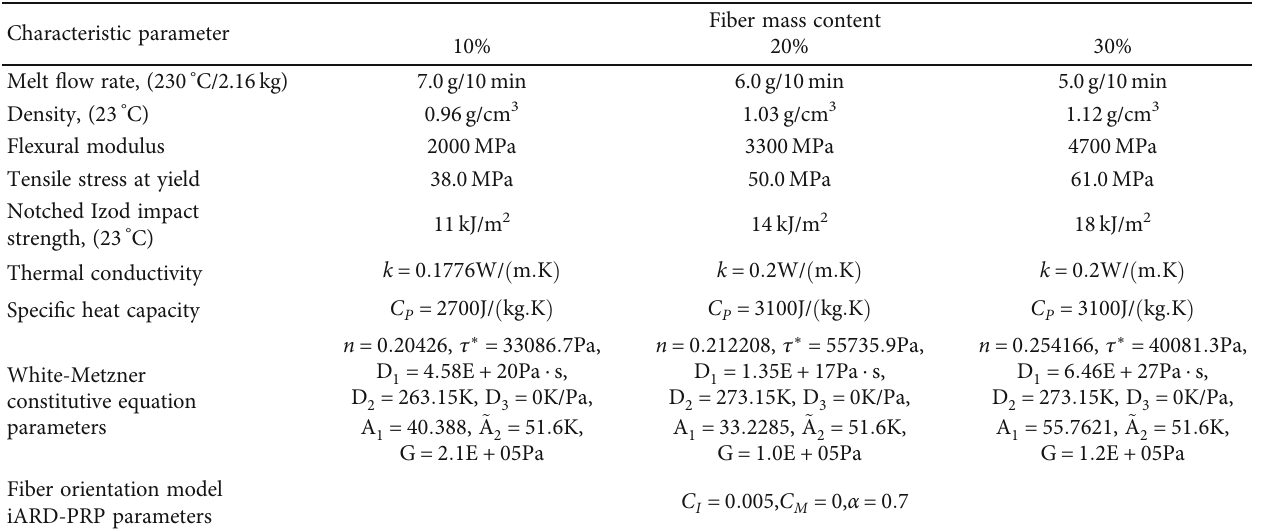
Table 1: Characteristics of polypropylene-based short fi ber